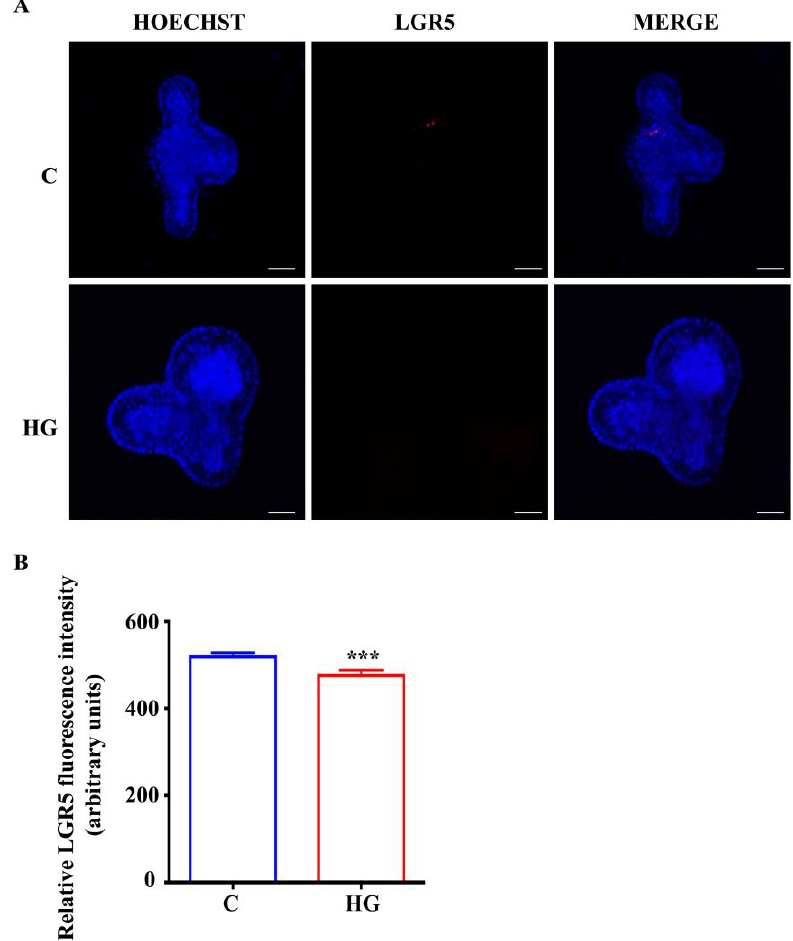
Figure 7. Expression of LGR5 in small intestinal organoids. ( A ) Representative images of controls and organoids treated with high glucose (35 mM) for 48 h. Intestinal stem cells, inside organoids, are labeled in red by LGR5 expression. Nuclei are labeled by Hoechst. Scale bar, 50 μm. ( B ) Quantification of the LGR5 fluorescence intensity. (n = 6). Data are expressed as means ± SEM. Unpaired Student t -test: *** p < 0.001. C = Control (17.5 mM glucose). HG = High Glucose (35 mM glucose).